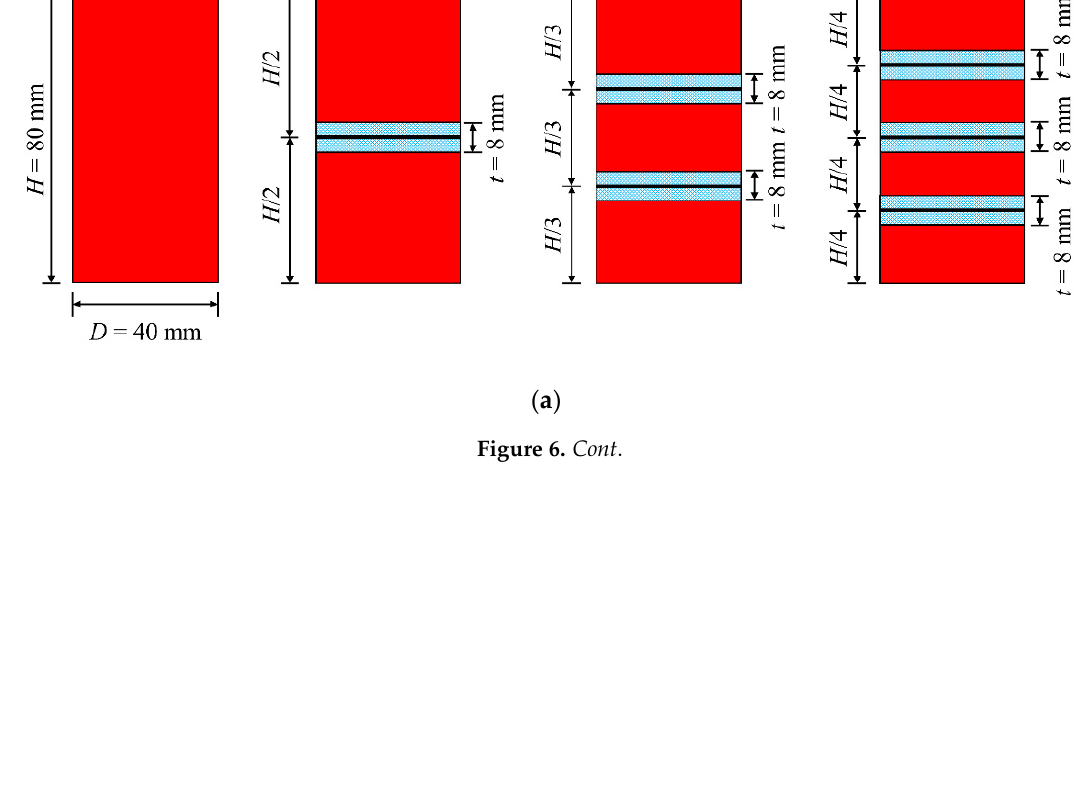
Figure 6. The scheme for the numerical triaxial compression test on the LGSCR samples: ( a ) different numbers of layers; ( b ) different thicknesses of layers. 4. Results and Discussion 4.1. Relationship between Deviatoric Stress and Axial Strain Figure 7 delineates the deviatoric stress–axial strain curves of the SCL samples at confining pressures of 150, 250, and 400 kPa and different numbers of sand layers. As can be seen in Figure 7, the SCL samples ( n = 1, 2, 3) have a higher peak stress ( σ p ) under specific confining pressures than the pure clay sample ( n = 0). The σ p of the samples also enlarges with an increase in the number of sand layers. It should be noted that increasing n gradually reduces the strain-softening degree of the samples but enlarges the axial strain ( ε n ) corresponding to the σ p . The smaller the confining pressure is, the more significant the increasing trend of the ε n corresponding to the σ p with n becomes. The above results demonstrate that laying the sand layers in the sample can significantly improve the post- peak characteristics of the samples; furthermore, the larger the number of sand layers is, the more pronounced the effect becomes. In practical engineering, the sand layers can be laid in the clay filler, which can effectively avoid the sudden damage to the soil structure caused by the rapid decrease in its strength during large deformations, thereby improving the safety of the soil structure.